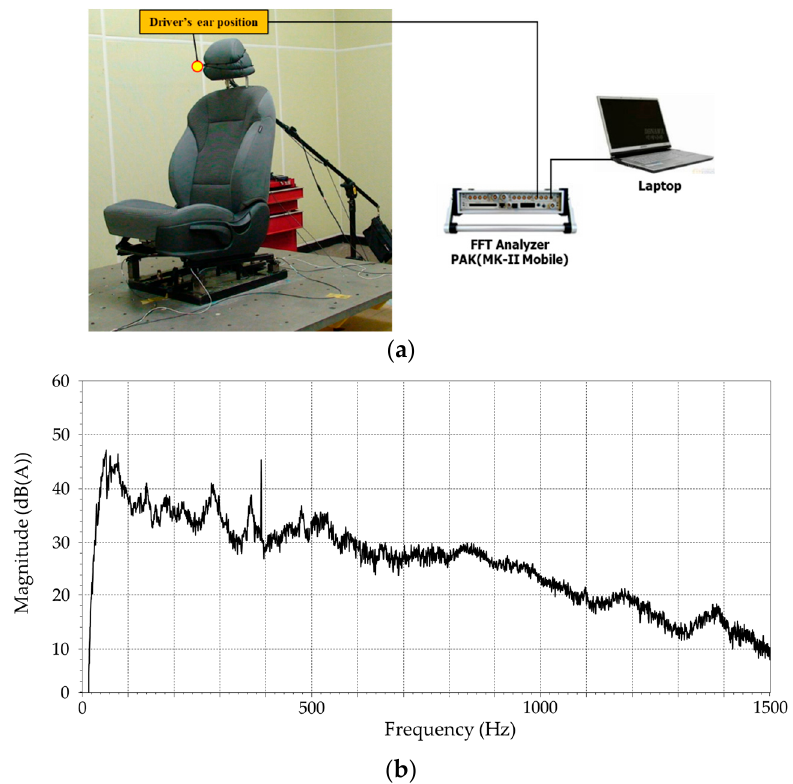
Figure 9. Experimental setup and seat noise at driver’s ear position: ( a ) experimental setup, ( b ) seat noise result.